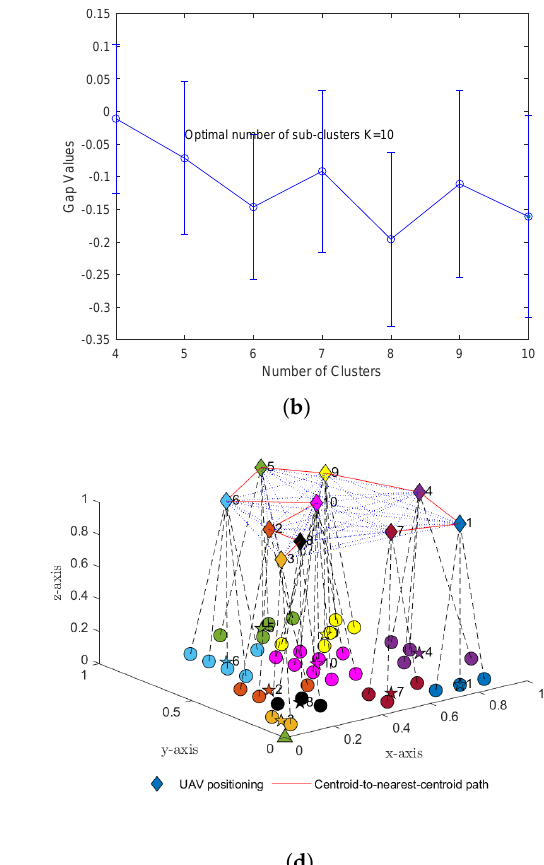
Figure A1. The randomly distributed WSN ( a ), determined optimal number of subclusters K ( b ), division into subclusters ( c ) and centroid-to-next-nearest-centroid trajectory ( d